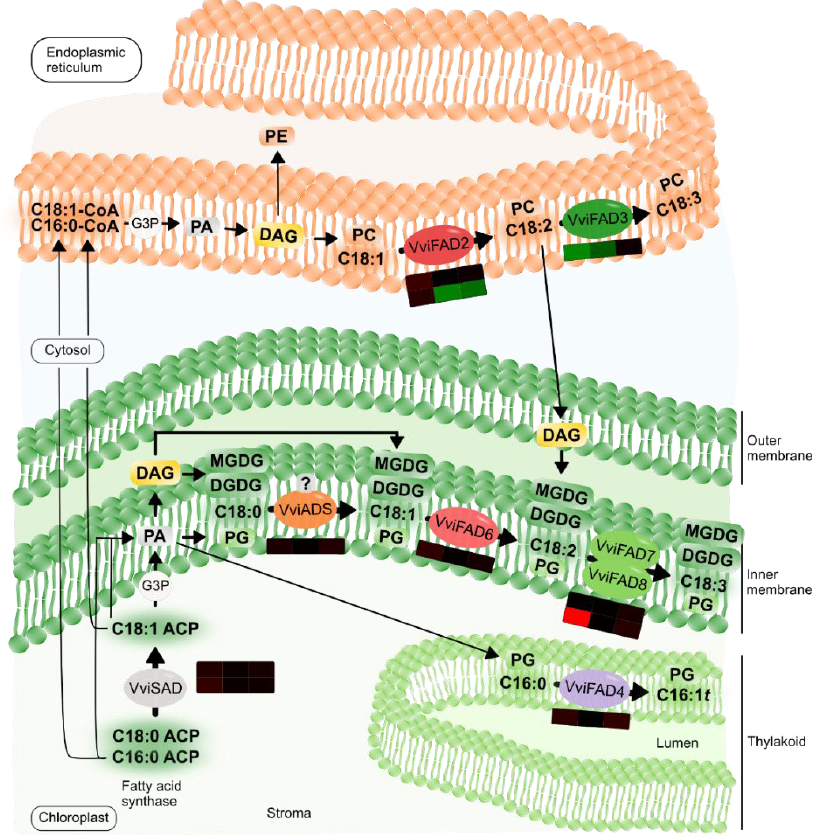
Figure 7. Lipid and FA metabolism, catalysed by the action of FA desaturases, in V. vinifera cv. Regent leaves upon inoculation with P. viticola . The gene expression regarding each grapevine desaturase encoding gene is represented by the respective heatmap as presented in (Figure 5).